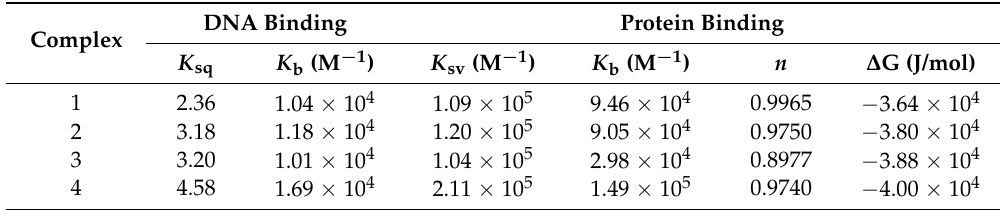
Table 1. The comparison of the interaction study results between complexes 1 – 4 on CT-DNA and